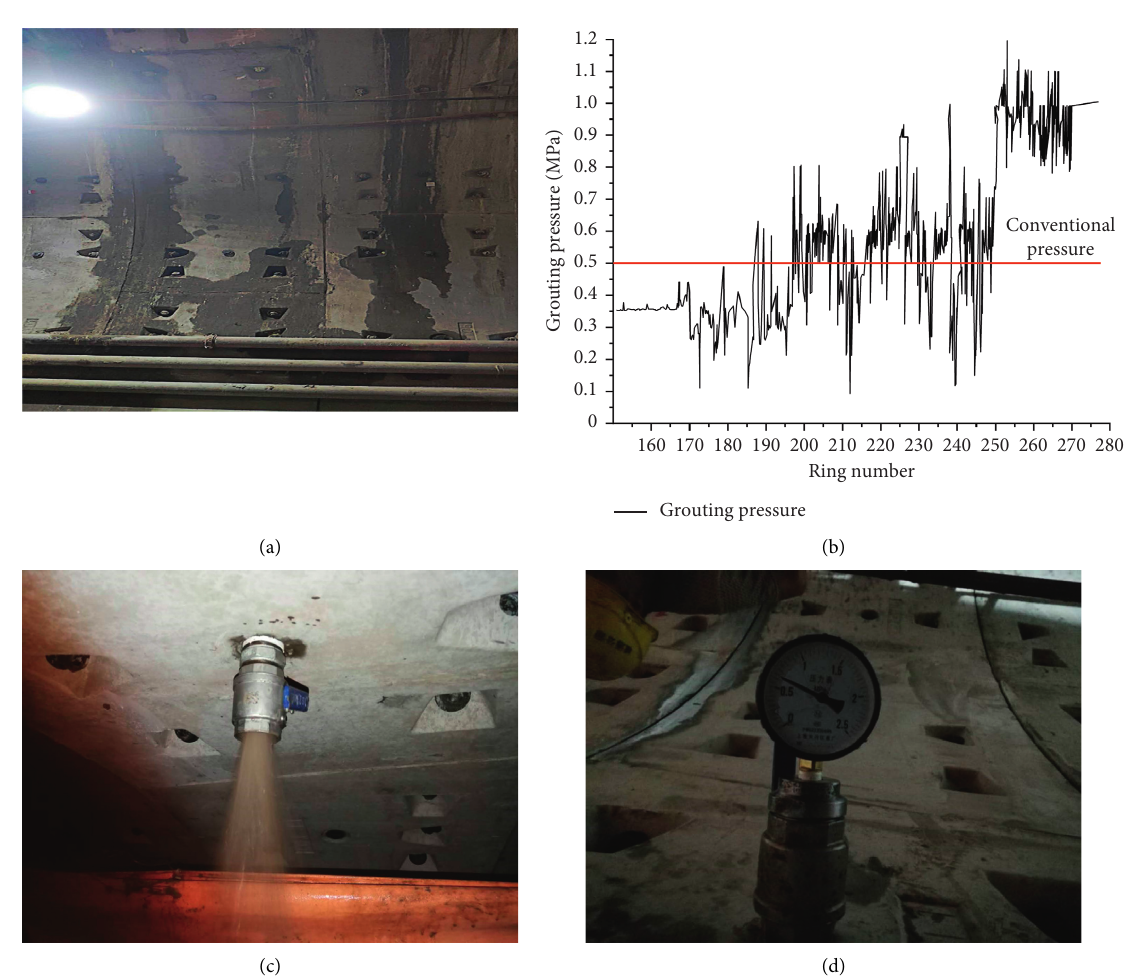
Figure 3: Field disease condition. (a) Seepage of the pipe segment. (b) Synchronous grouting pressure. (c) Flow condition of synchronous grouting line. (d) Field hydraulic